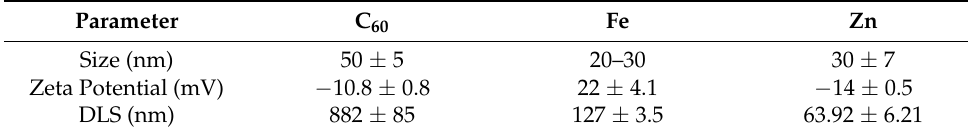
Table 1. Properties of carbon and metal-based